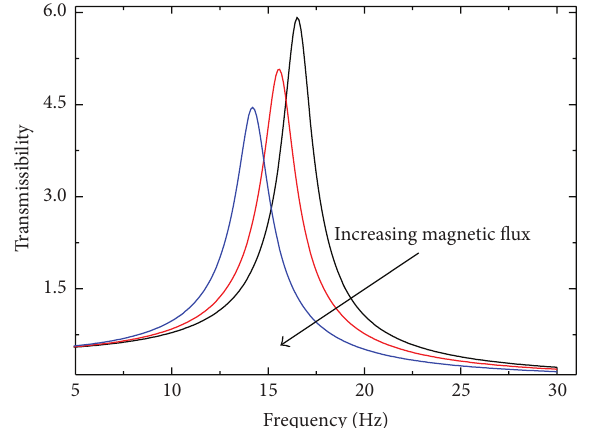
Figure 5: Transmissibility of the isolation system.